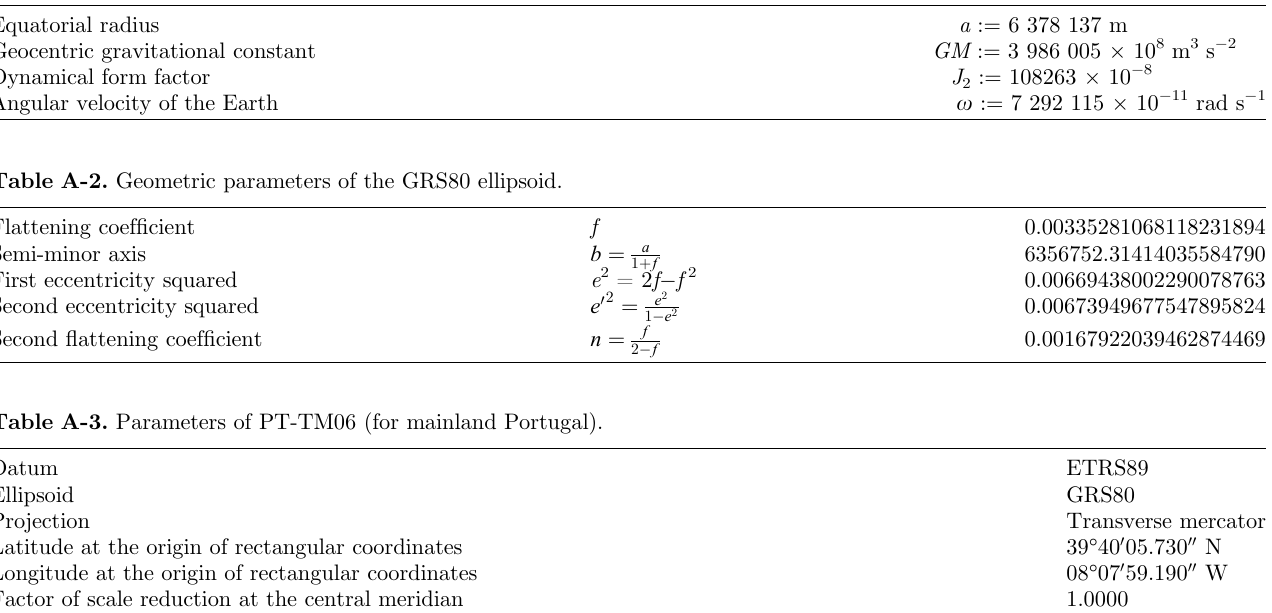
Table A-1. Parameters of the GRS80